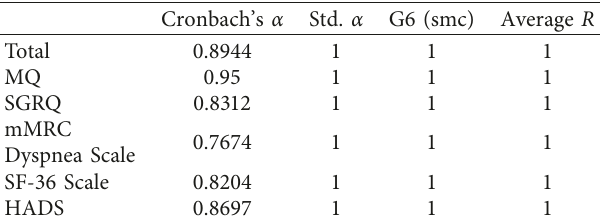
Table 3: Cronbach’s α coefficient for the five questionnaires conducted.